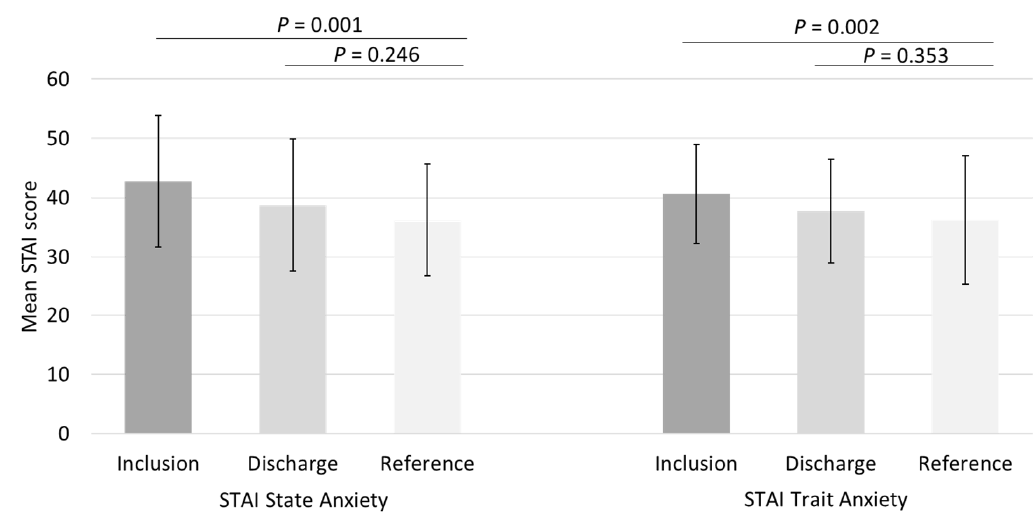
Figure 3. Maternal State and Trait anxiety scores 2 weeks after birth and at discharge, compared with the reference population of working women aged 19–39 years. STAI—State and Trait Anxiety Inventory.